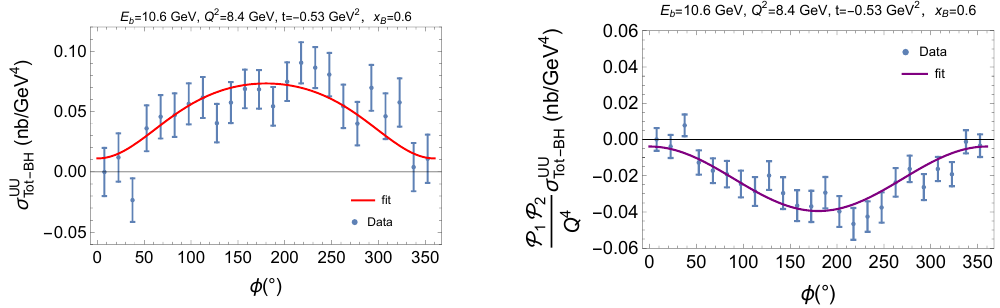
Figure 3. Comparison of fitting a harmonic parameterization to both the BH-subtracted UU cross section (left) and the reduced UU cross section (right) which was discussed in section